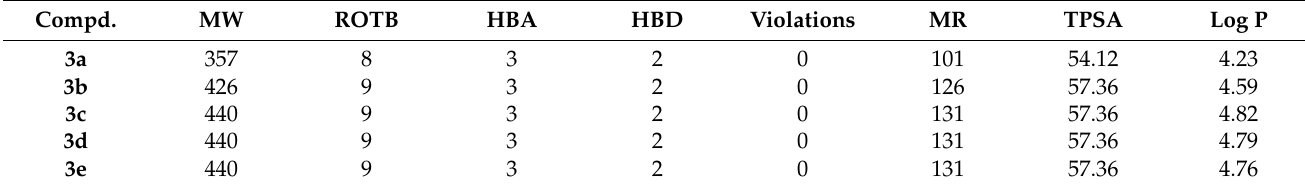
Table 6. Physicochemical and pharmacokinetic properties (Lipinski parameters) of compounds 3a–e . Compd.